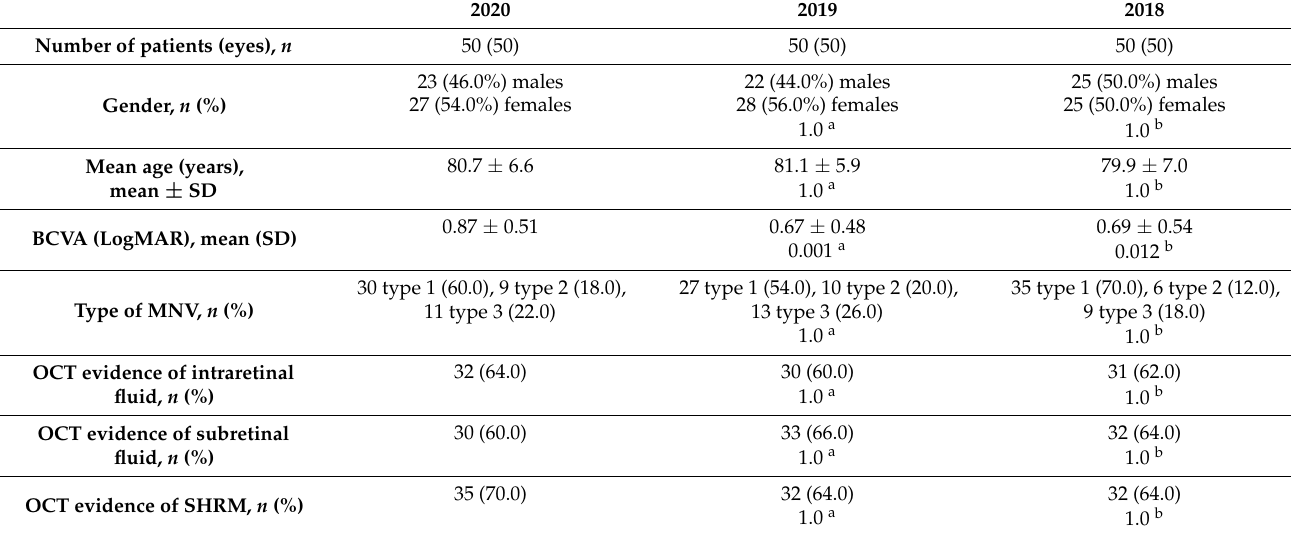
Table 1. Characteristics of analyzed patients in the three study